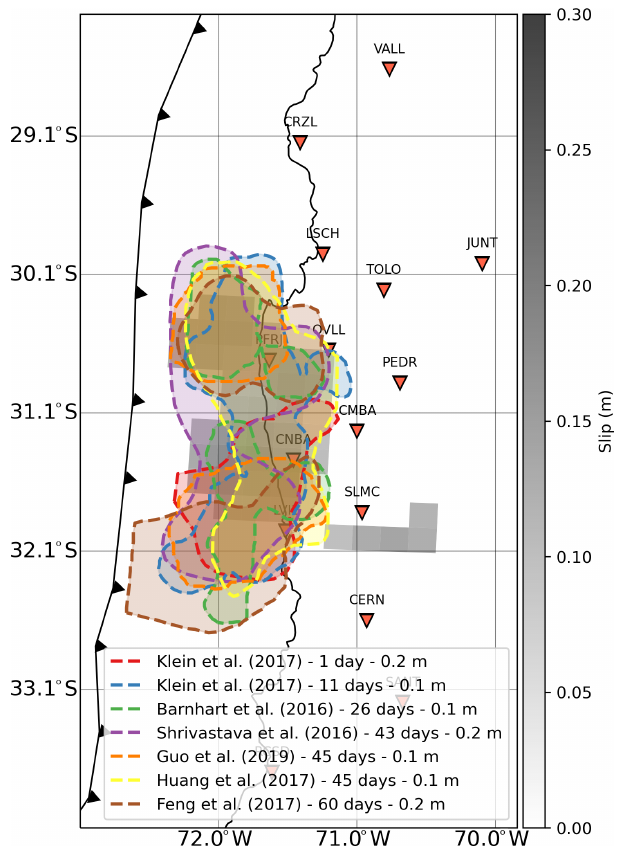
Figure 4. Comparison between post-seismic slip 12h after the mainshock (slip from our study in grayscale) and post-seismic slip from 1d and up to several weeks after the mainshock (dashed lines). Klein et al. (2017) use GNSS data and look at the shorter time pe- riod (1 and 11d). Barnhart et al. (2016) use both GNSS and In- SAR data to model post-seismic slip after 26d. Shrivastava et al. (2016) use GNSS data to investigate post-seismic slip after 43d. Guo et al. (2019) also use GNSS data to image post-seismic slip af- ter 1.5 months. The post-seismic slip distribution taken from Huang et al. (2017), using GNSS and InSAR data, is also after 1.5 months. Finally, the model obtained by Feng et al. (2017) uses geodetic data to look at post-seismic slip after 2 months. Numbers beside the ref- erences show the slip isoline amount. Symbols are the same as for Fig. 1.